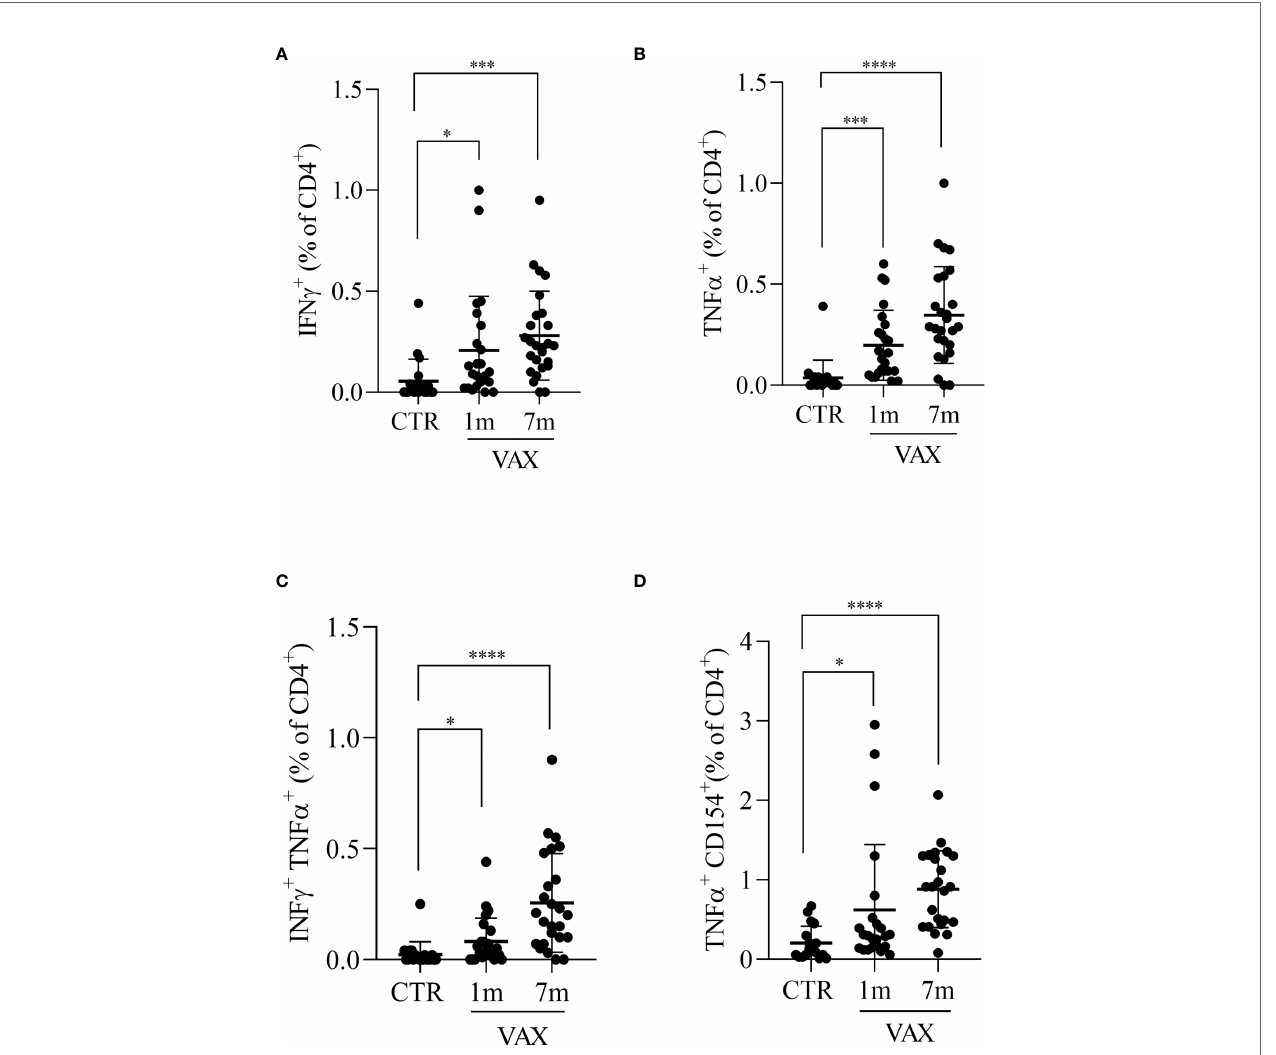
FIGURE 2 | Analysis of CD4 + T lymphocytes response to Spike derived peptides. Total PBMCs were stimulated in vitro with a pool of peptide derived from Spike (Wuhan variant). After 6 hours incubation in the presence of brefeldin A during the last 4 hours, PBMCs were stained and analyzed by fl ow cytometry for the production of INF g (A) , TNF a (B) , for the simultaneous production of INF g and TNF a (C) , or for the production of TNF a in CD154+ CD4+ T lymphocytes (D) . Cells from immunized subjects, analyzed at 1 and 7 months after vaccination cycle completion, were compared with cells from not-vaccinated controls (CTR). Data were analyzed using Mann-Whitney U-test *p<0.05; ***p< 0.001;